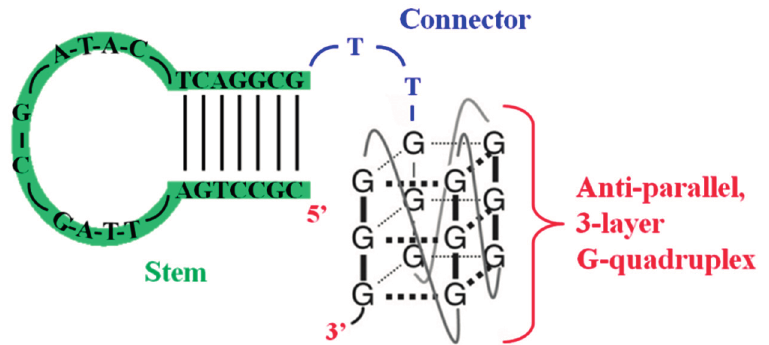
Figure 5. Model structure and sequence of RT6 aptamer described in ref.